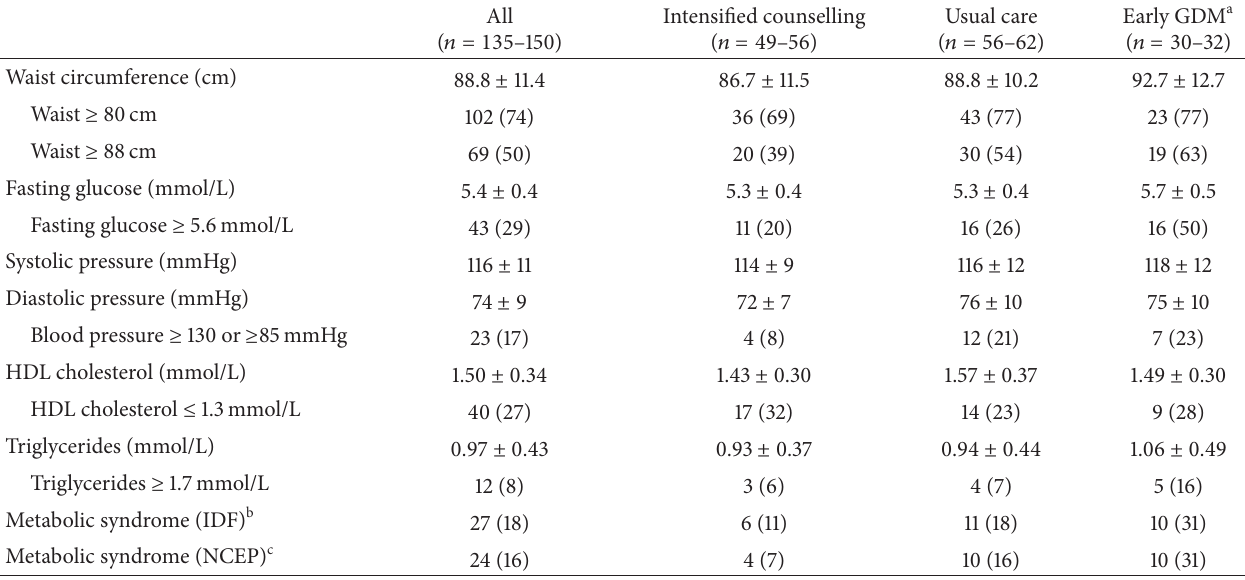
Table 3: Occurrence of metabolic syndrome by its explanatory variables (group, age, and five GDM risk factors). Odds ratios (ORs), 95% confidence intervals (CIs), and 𝑃 values, 𝑛 = 150 . Multivariate logistic regression model.